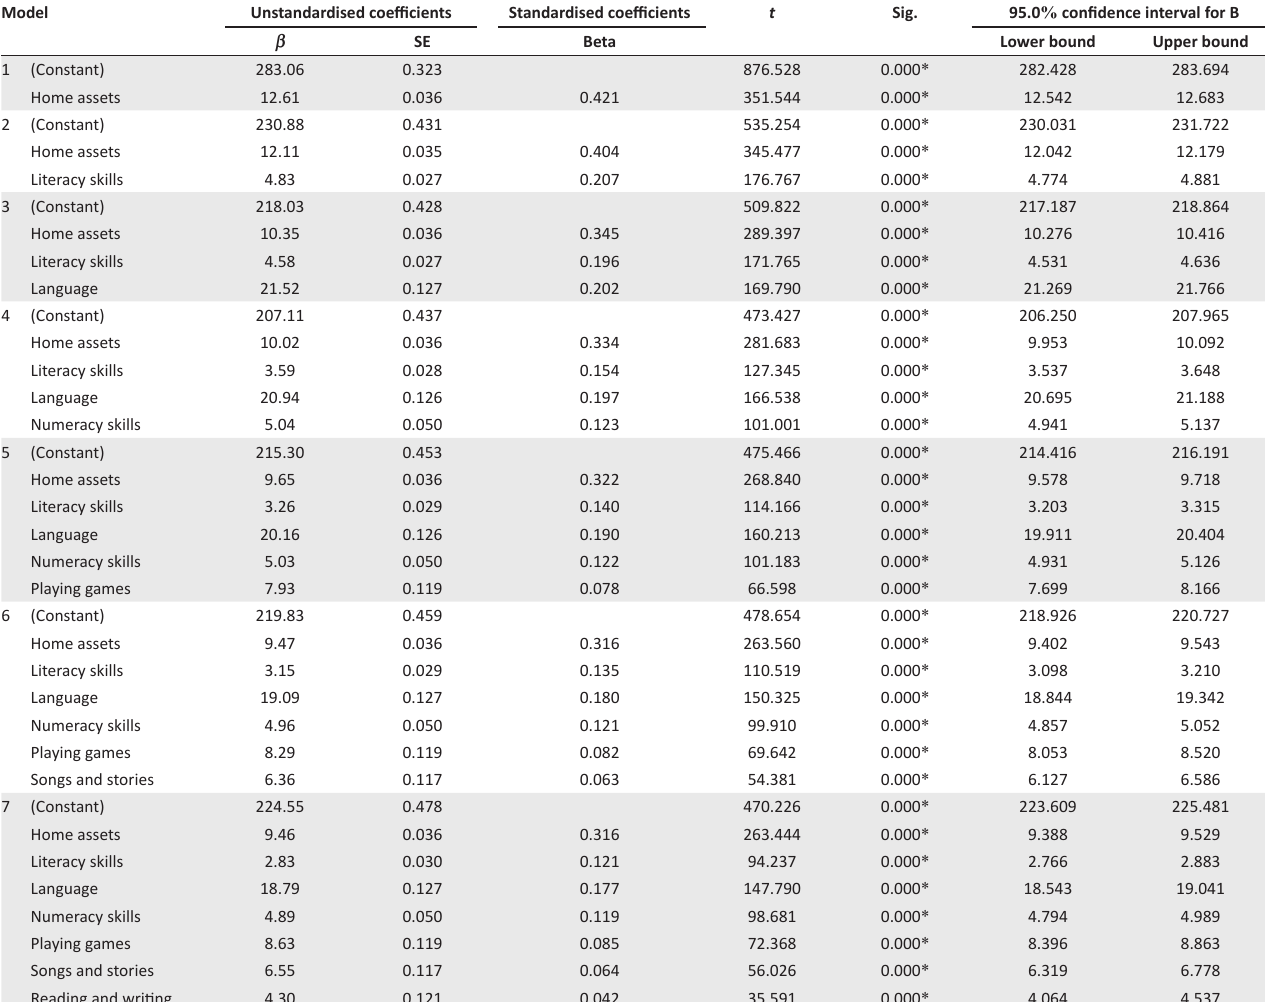
TABLE 6: Results of a stepwise regression analysis showing the association between early learning activities at home, pre-Grade 1 literacy and numeracy skills, socio-economic status, frequency of speaking the test language and mathematics performance.